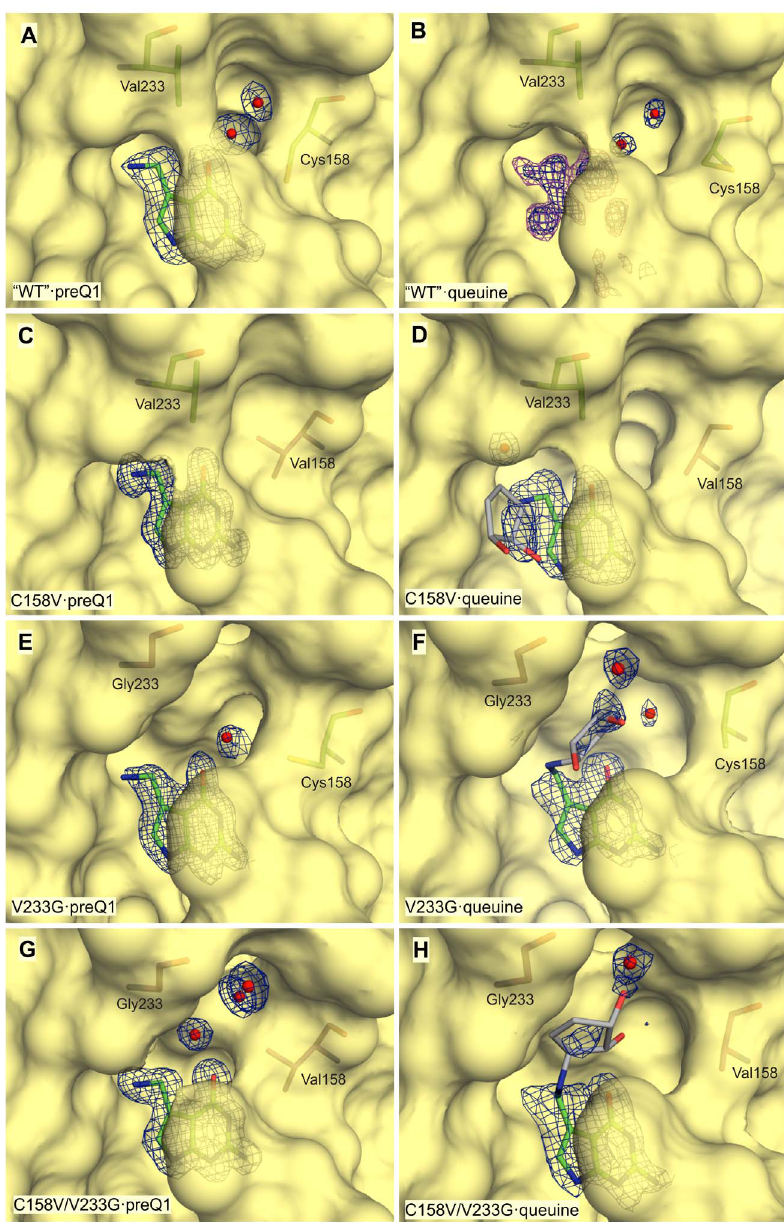
Figure 7. Crystal structures of Tgt variants in complex with preQ 1 or queuine: surface representation of substrate pockets. The solvent accessible surfaces of active sites from Z. mobilis Tgt variants are shown in bright yellow. The respective Tgt variant plus the bound ligand (shown in stick representation) are indicated in each sub-figure. Also amino acid residues at positions 158 and 233 are shown in stick representation. Carbon atoms of original amino acids and of the bound ligand are coloured green, those of mutated amino acids magenta. As the electron density assignable to the dihydroxy-cyclopentenyl moiety of queuine is poorly defined in all structures containing this ligand the coordinates of this moiety are not present in the respective structures deposited with the Protein Data Base. Accordingly, the conformations of the dihydroxy-cyclopentenyl shown in (D), (F) and (H) are tentative. To indicate this fact, the carbon atoms of this moiety are shown in grey. Selected water molecules are shown as red spheres. 2|F o |-|F c | (at s 1.0) electron density is shown for the bound ligand and water molecules. 2|F o |-|F c | electron density contoured at a s level of 1.0 is coloured blue, |F o |-|F c | electron density contoured at a s level of 2.5 is coloured magenta. An overview of the crystal structures analysed in this study including resolutions and PDB codes is given in Table S1. doi:10.1371/journal.pone.0064240.g007 is not concomitant with a rotation of the Thr159 side chain density maps of apo- and preQ 1 -bound Tgt(Cys158Val) and (Figure 9C). Tgt(Cys158Val/Val233Gly). The positioning of the Val158 main Also the electron density maps of the Tgt(Val233Gly) ? queuine chain atoms, however, suggests a significant shift of this residue and Tgt(Cys158Val/Val233Gly) ? queuine complex structures en- towards the bound ligand although less pronounced as observed in abled reliable placement of the 7-deazaguanine scaffold of the the preQ 1 complex structure of Tgt(Cys158Val). In accordance ligand which is, in both cases, similarly bound as in the with the structure of the guanine-bound Tgt(Cys158Val), this shift